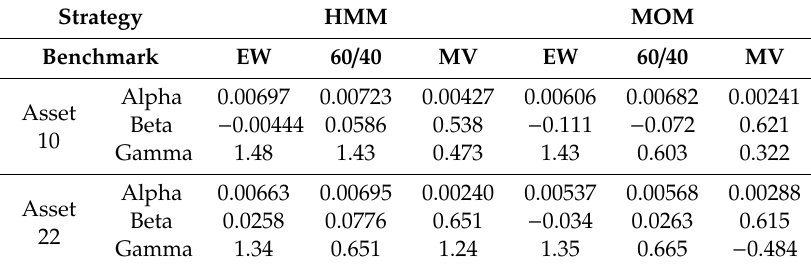
Table 9. Treynor-Mazuy Measure